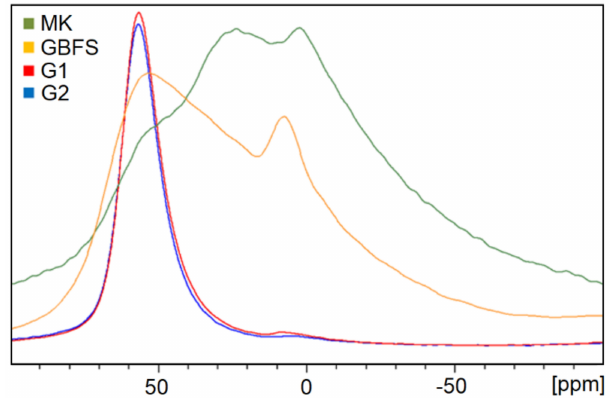
Figure 8. 27 Al MAS-NMR of matrices G1 and G2 compared with metakaolin (MK) and ground- granulated blast-furnace slag (GBFS).